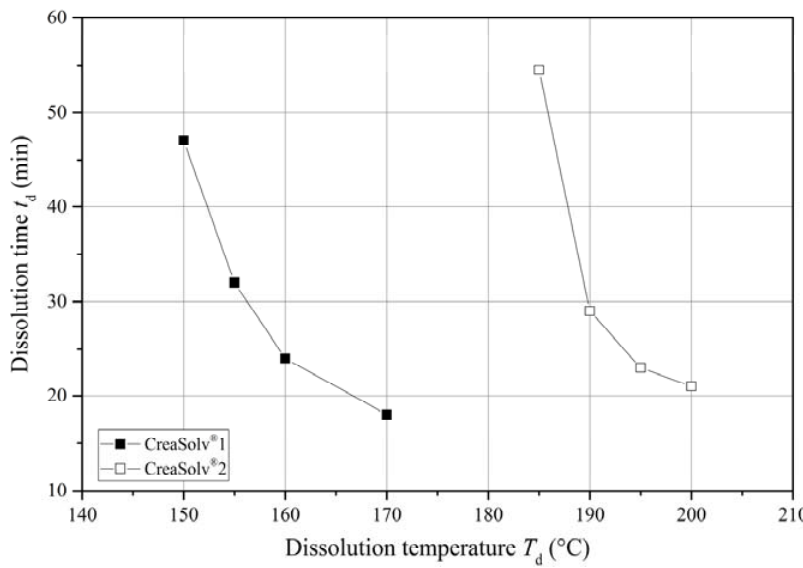
Figure 3. Diagram showing the dissolution time t d depending on the dissolution temperature T d using the two candidate solvent formulations CreaSolv ® 1 and 2, respectively.